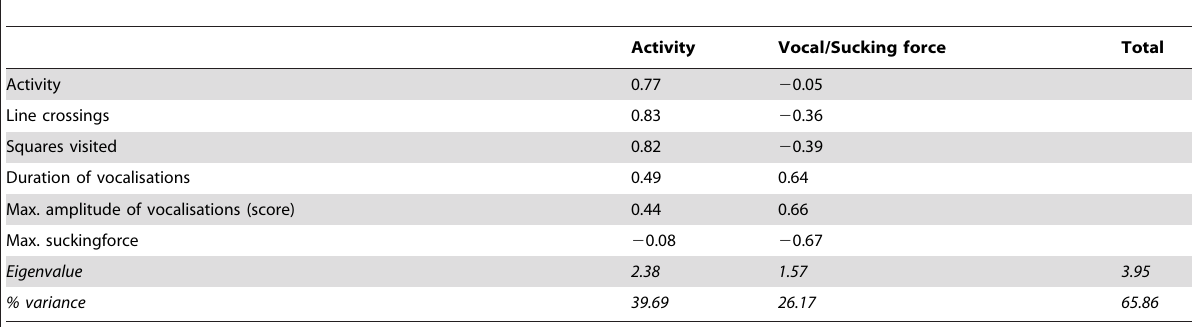
Table 7. Components and component loadings of the CATPCA over the neonate test.